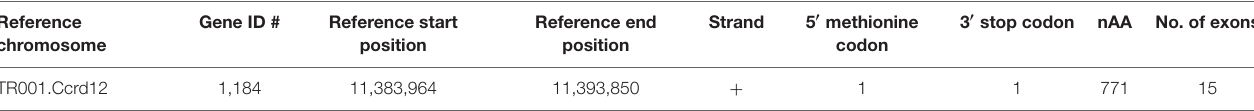
FIGURE 4 | Leaf width and associated genotypes in native and invasive populations of Centaurea diffusa . Distribution of leaf width and associated allele across native and invasive populations. (A) Maximum leaf width of native and invasive plants. (B) The effect of genotype at position TR001.Ccrd12_11392699 on maximum leaf width. All pairwise differences are significant according to a Tukey test (CC vs. CT: p = 0.03, CC vs. TT: p < 0.0001, CT vs. TT: p < 0.0001). (C) Mosaic plot showing the frequency of genotypes at position TR001.Ccrd12_11392699 in native and invasive populations. The width of each bar is proportional to the sample size. * p < 0.05, *** p < 0.00. TABLE 2 | Significant GWAS association mapped to Centaurea diffusa draft reference